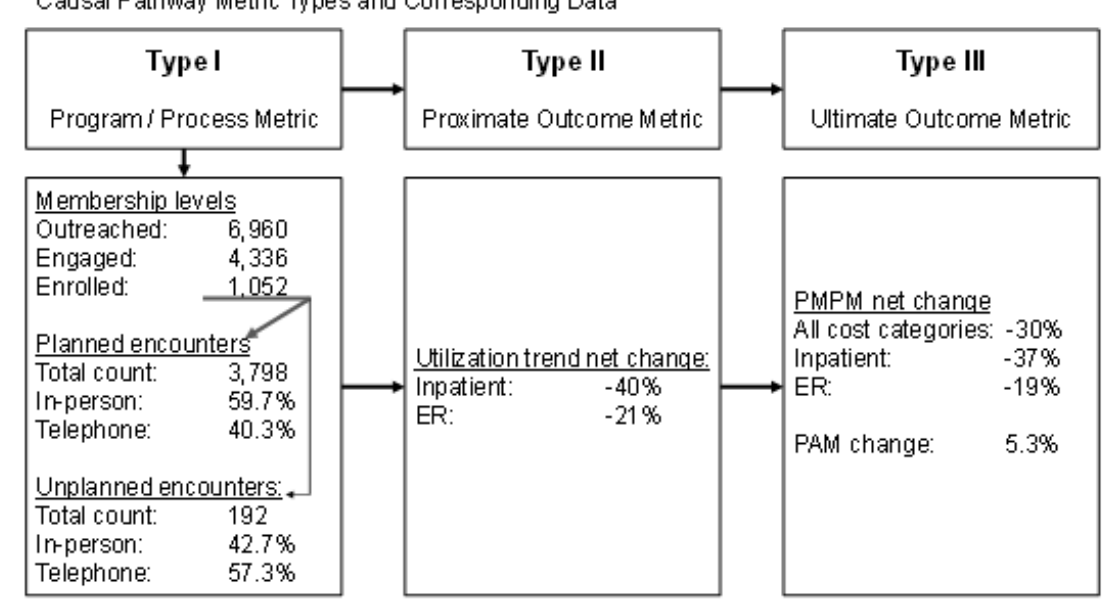
Figure 2. Causal Pathway Metric Types and Corresponding Data